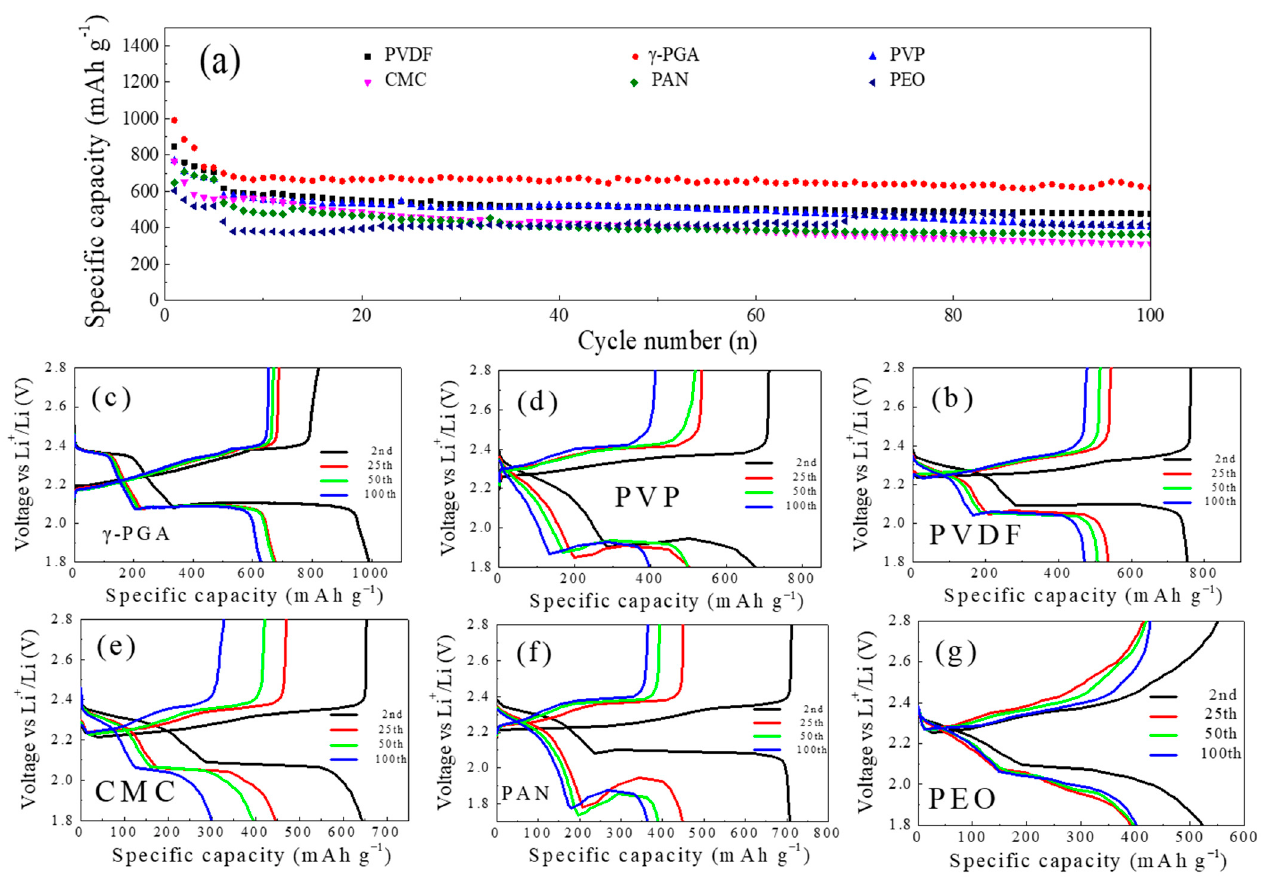
Figure 4. ( a ) Cycling performance and the charge/discharge profiles of Li-S batteries with different binders: ( b ) PVDF, ( c ) γ -PGA, ( d ) PVP, ( e ) CMC, ( f ) PAN and ( g ) PEO binders.